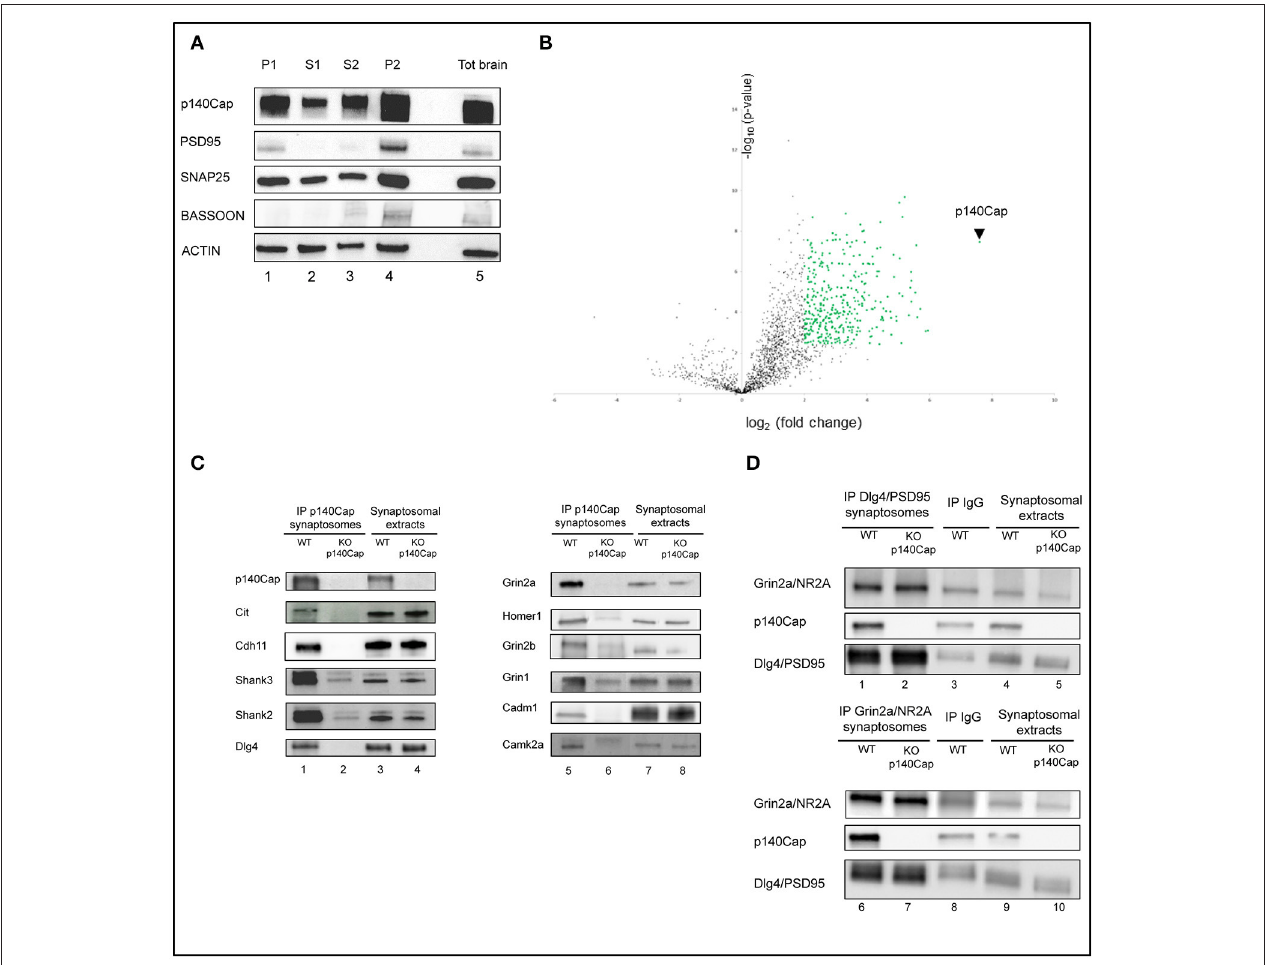
FIGURE 1 | Identification and validation of p140Cap interactors. Enrichment of synaptic markers in the synaptosomal preparation. (A) Validation of the synaptosomes. Western blot for p140Cap, PSD-95, Snap25, Bassoon and beta-actin fractions isolated during synaptosomal preparation. Lane 1, nuclear fraction (P1); lane 2, first cytosolic fraction (S1); lane 3, second cytosolic fraction (S2); lane 4, crude synaptosome (P2), lane 5, total brain extracts (see Figure S1 for details). (B) Statistically enriched proteins in the p140Cap IP. The Volcano plot represents the log 10 ( p -value, y axis) plotted against the log 2 (fold change, x axis) for proteins quantified in p140Cap IPs from WT and p140Cap KO, used as negative control. 357 different proteins, including p140Cap (arrowhead) were found significantly enriched in WT samples (FDR ≤ 1%, ≥ 4-fold enrichment) are shown as green dots (C) Validation of synaptic p140Cap interacting proteins identified in the interactome. Lane 1 and 5, p140Cap IP in WT animals; lane 2 and 6, p140Cap IP in p140Cap KO animals; lane 3 and 7, input from WT synaptosomes; lane 4 and 8, input from KO synaptosomes. Co-immunoprecipitated proteins are shown on the left, along with their rank in MS. (D) Reverse validation for p140Cap interacting